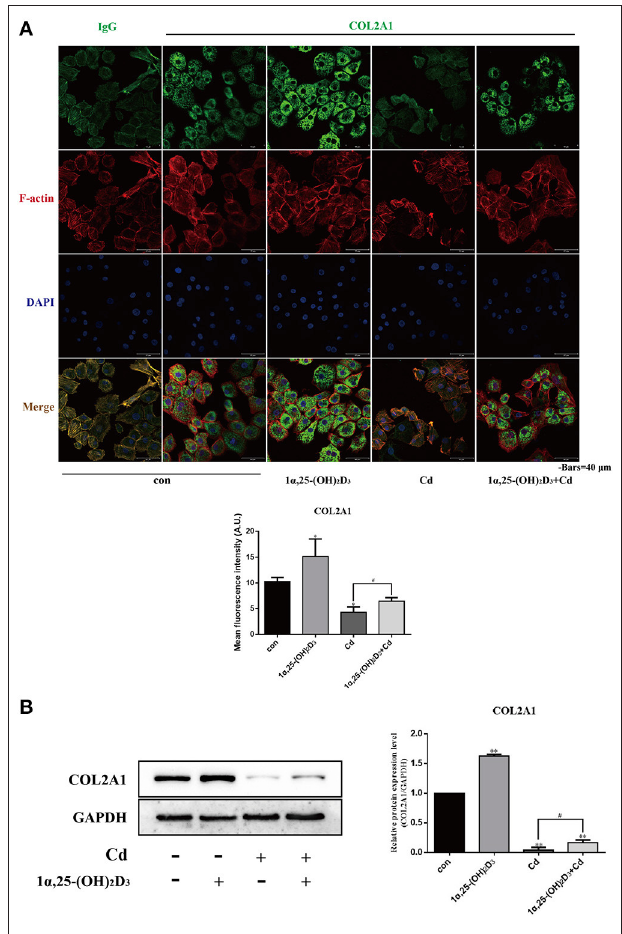
FIGURE 6 | 1 α ,25-(OH) 2 D 3 relieved the inhibitory effect of Cd on the expression of COL2A1 in chondrocytes. (A) Immunofluorescence staining of COL2A1 in chondrocytes pretreated with 10 − 8 M 1 α ,25-(OH) 2 D 3 for 1 day followed by 3 days of combined treatment with 2 µ M Cd. Compared with Cd treatment alone, the 1 α ,25-(OH) 2 D 3 and Cd combination treatment significantly increased the fluorescence signal of COL2A1 in chondrocytes. (B) Western blot of COL2A1 protein expression in chondrocytes pretreated for 1 day with 10 − 8 M 1 α ,25-(OH) 2 D 3 followed by 3 days of combined treatment with 2 µ M Cd for 3 days. Compared with the Cd treatment alone, the 1 α ,25-(OH) 2 D 3 and Cd combination treatment significantly increased COL2A1 expression in chondrocytes. All data are represented as mean ± standard deviation; n = 3; * P < 0.05 and ** P < 0.01, significant difference relative to the day 0 group; # P < 0.05 and ## P < 0.01, significant difference between the combination treatment group and Cd monotherapy